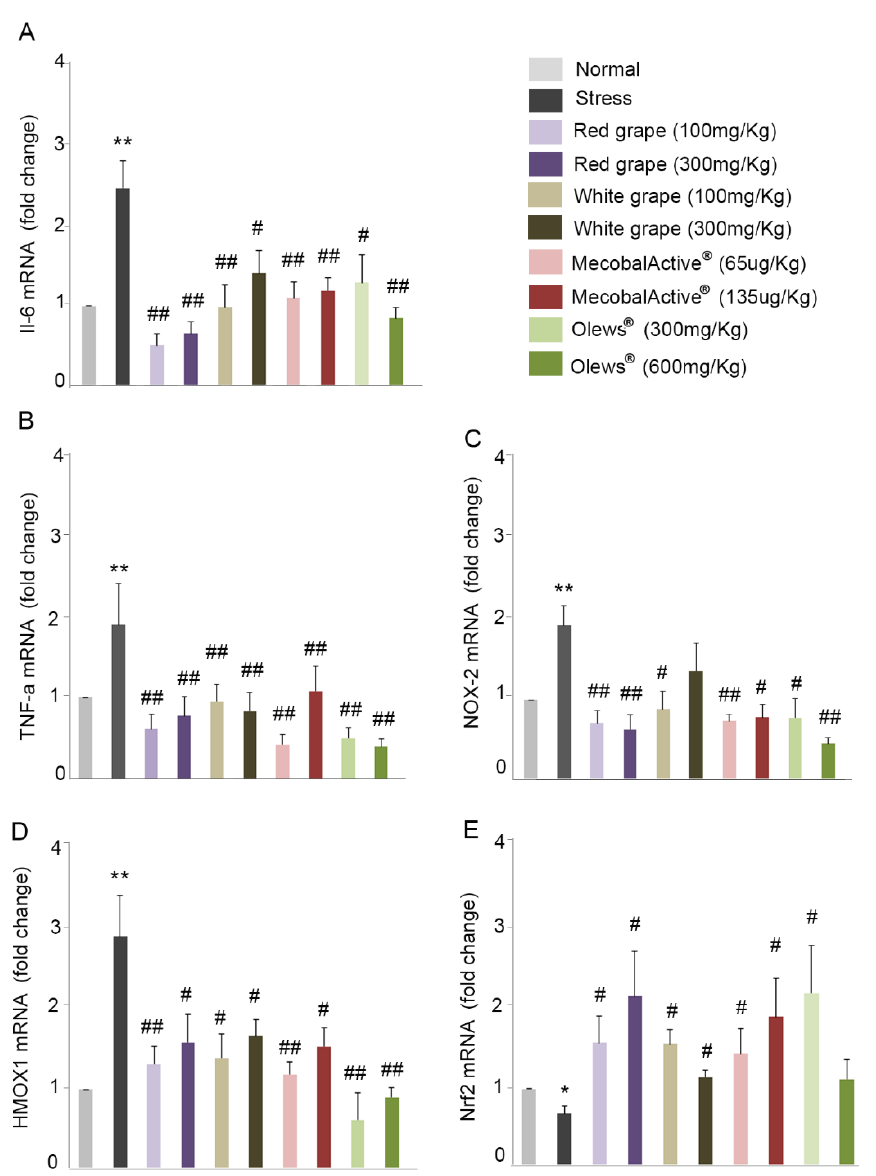
Figure 6. Natural extracts protect against oxidative stress. Red and white grape seed extracts, MecobalActive ® , and Olews ® were administered orally during 5 consecutive days. Then, mice were immobilized for 6 h. The mRNA expressions of IL-6 ( A ), TNF-alpha ( B ), NOX-2 ( C ), HMOX1 ( D ), and Nrf2 ( E ) were quantified in mouse brains by RT-PCR. Gene expression was normalized with GAPDH. All data were normalized to levels found in nonstressed mice (normal) and are expressed as a fold change. Values are presented as mean ± SEM from eight experimental animals. One-way ANOVA and Dunnett’s multiple comparison post-hoc test were used for statistical analysis. ∗ p < 0.05 and ∗∗ p < 0.01 versus normal mice, and # p < 0.05 and ## p < 0.01 versus restrained mice (stress).